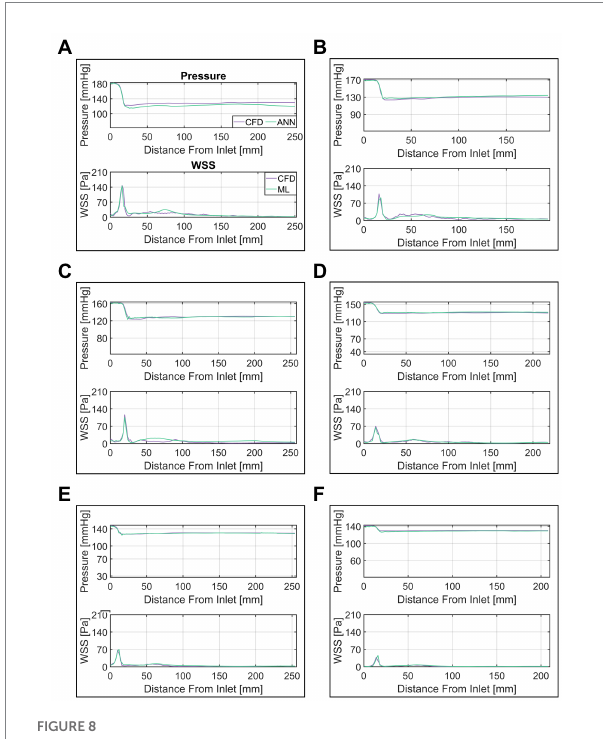
FIGURE 8 Comparison of ANN and CFD-based pressure and wall-shear-stress (WSS) along vessel centerline. Cases ( A–F) are ordered by descending